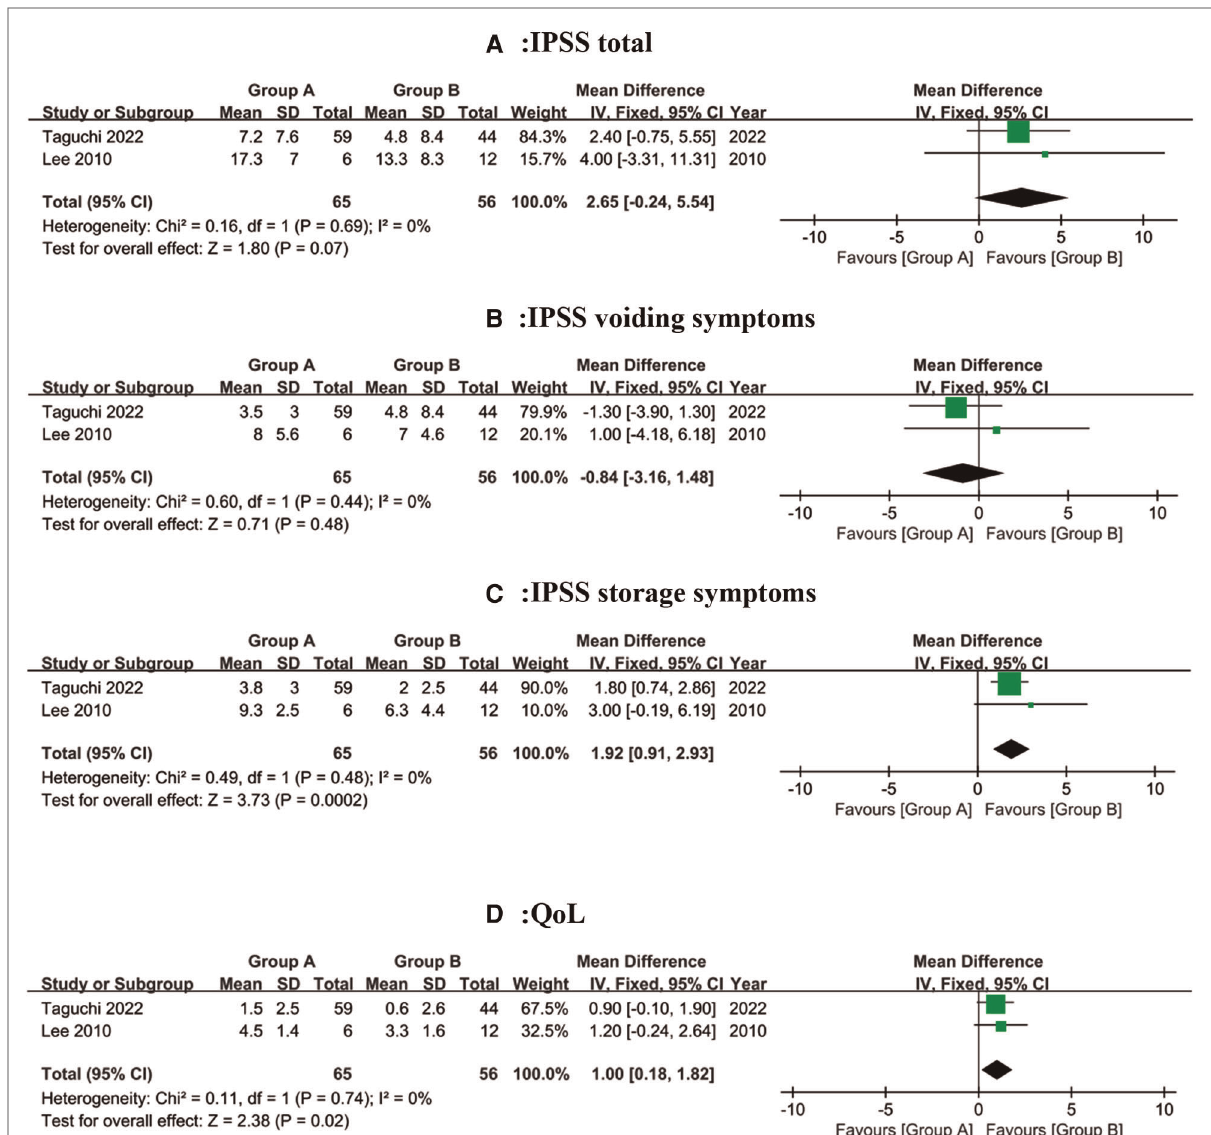
FIGURE 4 Forest plot depicting changes in IPSS and QoL